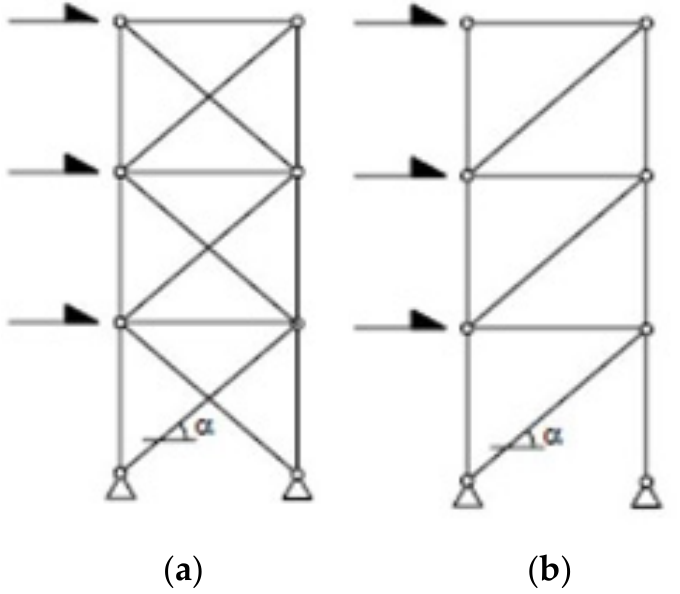
Figure 2. Modeling schemas of X-CBF according to the regulations, with both in-tension and compressed braces on the left ( a ), and with only the in-tension ones on the right ( b ).